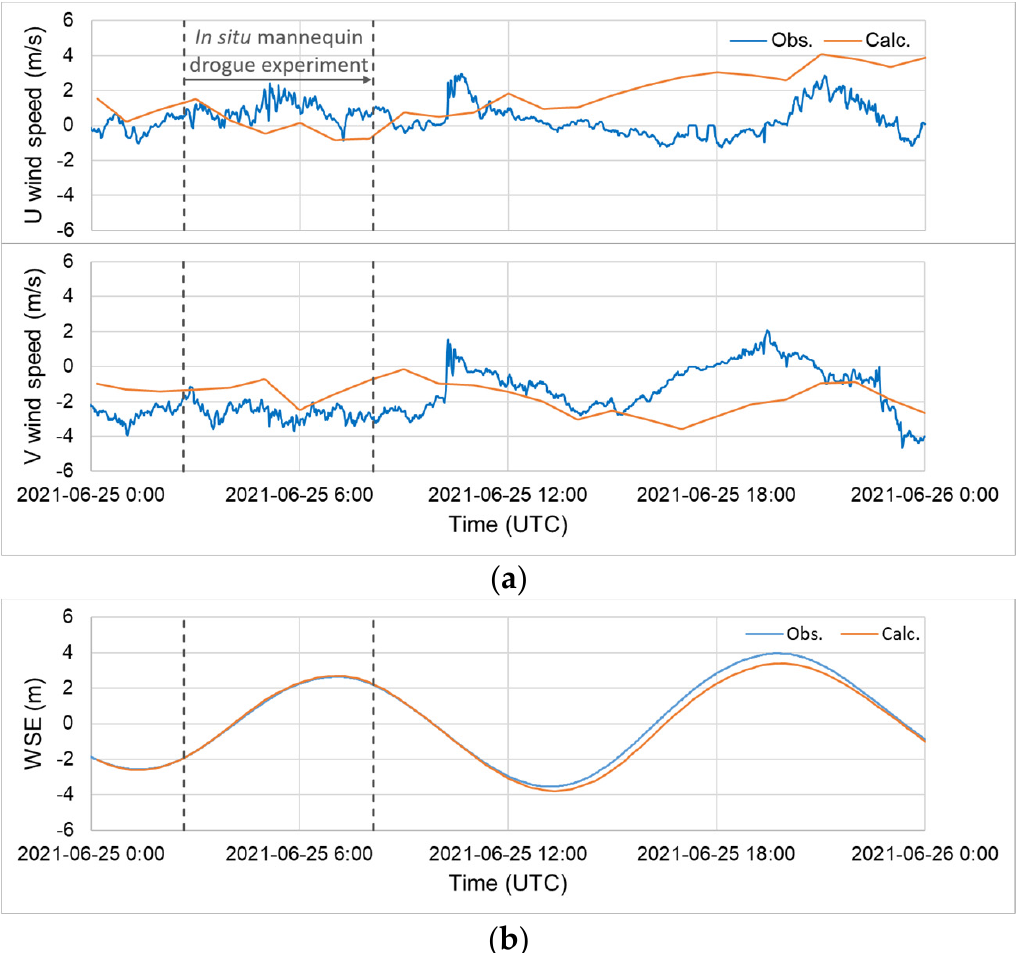
Figure 10. Comparison of wind speed ( a ) and water surface elevation ( b ) in Gadaeam and Taean (Figure